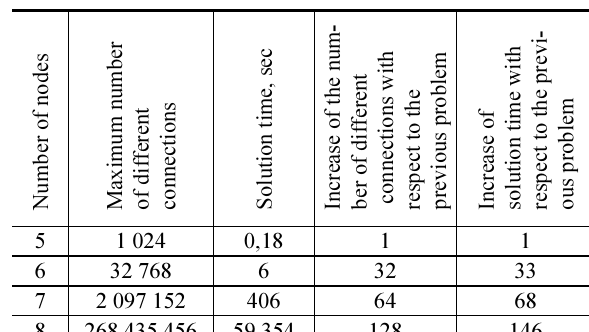
Table 1. Summary of results with an exhaustive search